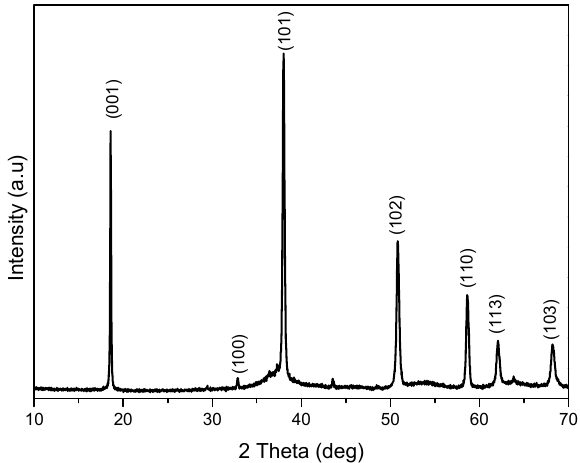
Figure 1. XRD of Mg (OH) 2 .